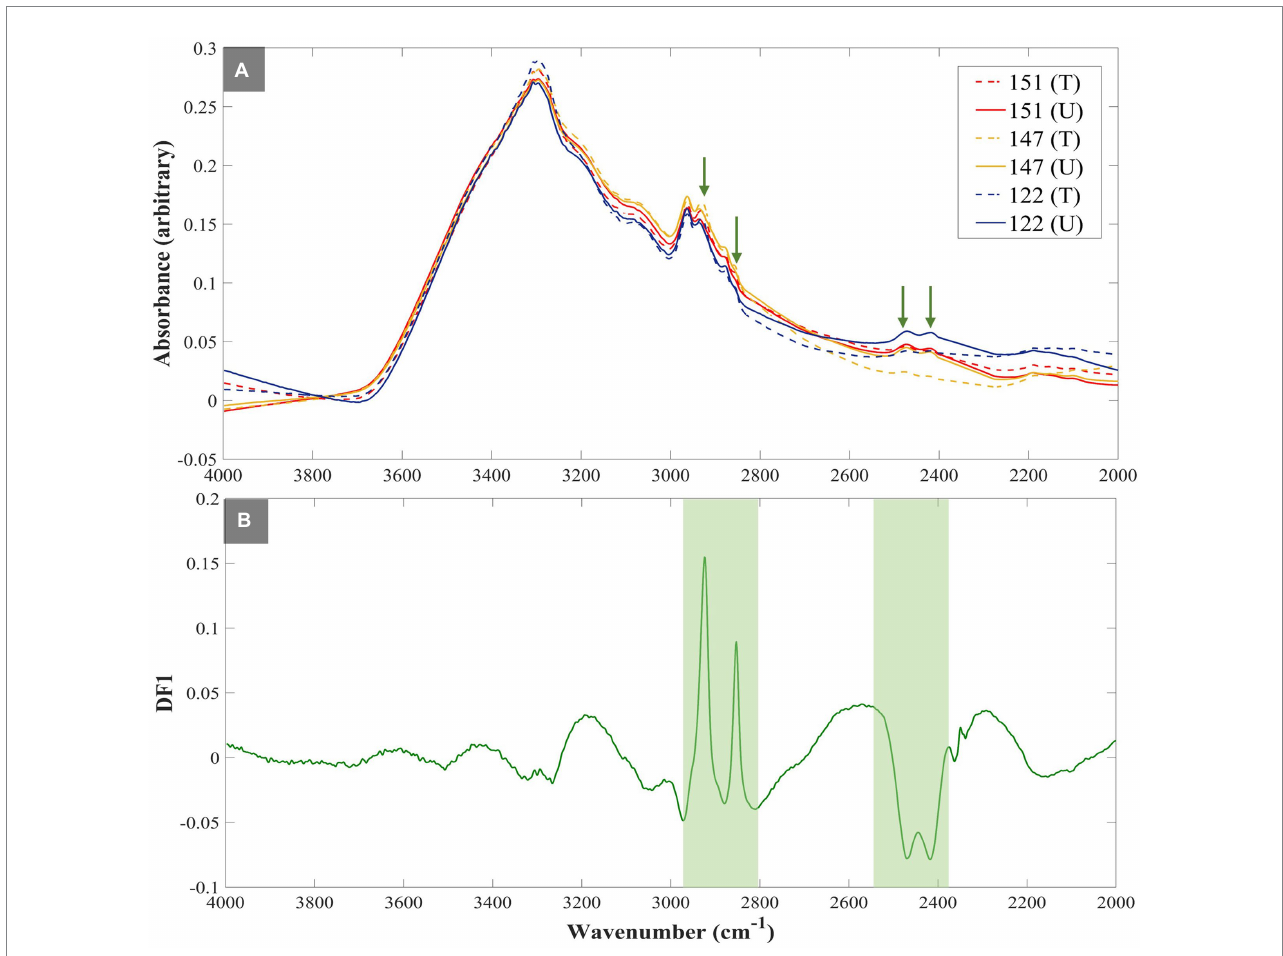
FIGURE 2 FT-IR spectra of susceptible UPEC isolates investigated in this study. The green arrows highlight the fatty acids’ CH 2 (at 2,925 cm − 1 and 2,854 cm − 1 ) and C–D stretching vibrations (at 2,471 cm − 1 and 2,418 cm − 1 ) (A) , DF1 loadings plot of FT-IR spectral data at 3h timepoint illustrating the most significant vibrational peaks (green strips) contributing to the discrimination patterns (B) . All spectra were normalized using extended multiplicative signal correction (EMSC). Each spectrum represents the average of four technical replicates. Different colored lines and numbers represent the different isolates, dotted lines represent treated groups, while untreated groups are represented as normal